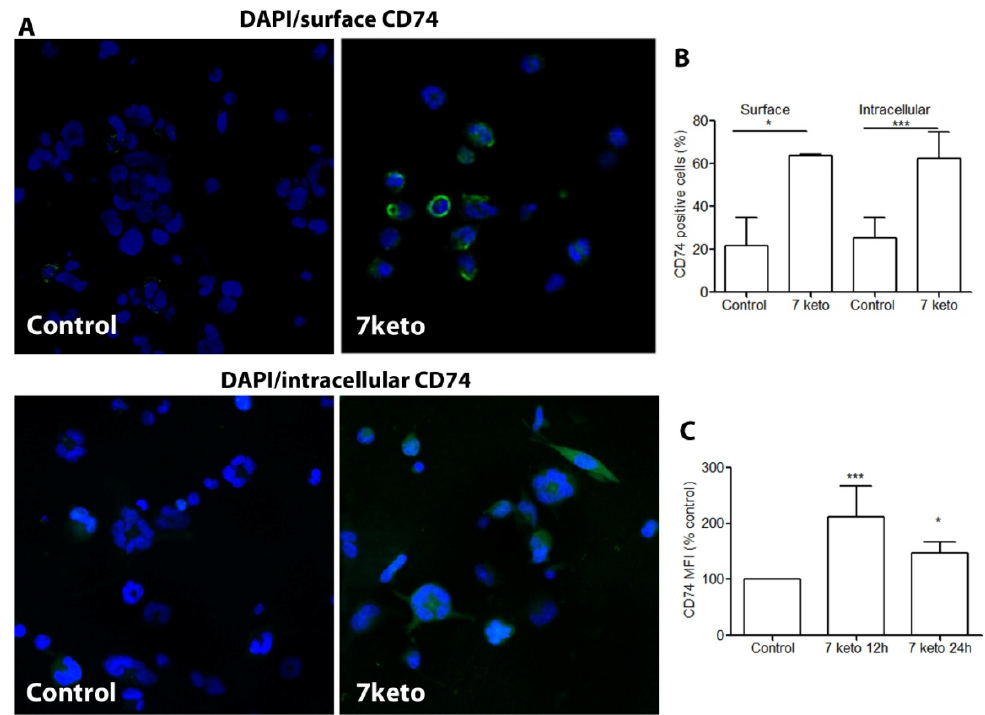
Figure 5. CD74 is increasingly expressed on the cell surface and intracellular space in THP-1 macrophages after exposure to 7keto. THP-1 macrophages were either left untreated or were treated with 7keto for 12 or 24 h. Following CD74 immunocytochemistry, separately for surface (no fixation and permeabilization) and intracellular expression, the cells were examined by confocal microscopy. ( A ) Representative photographs of surface and intracellular CD74. ( B ) Percentage of CD74 positive cells of surface ( n = 2) and intracellular levels ( n = 5) after 24 h. Data are mean ± SD. ( C ) CD74 mean fluorescence intensity (MFI,% of controls). Data are mean ± SD, n = 5. * p < 0.05 and *** p < 0.001 vs. control.